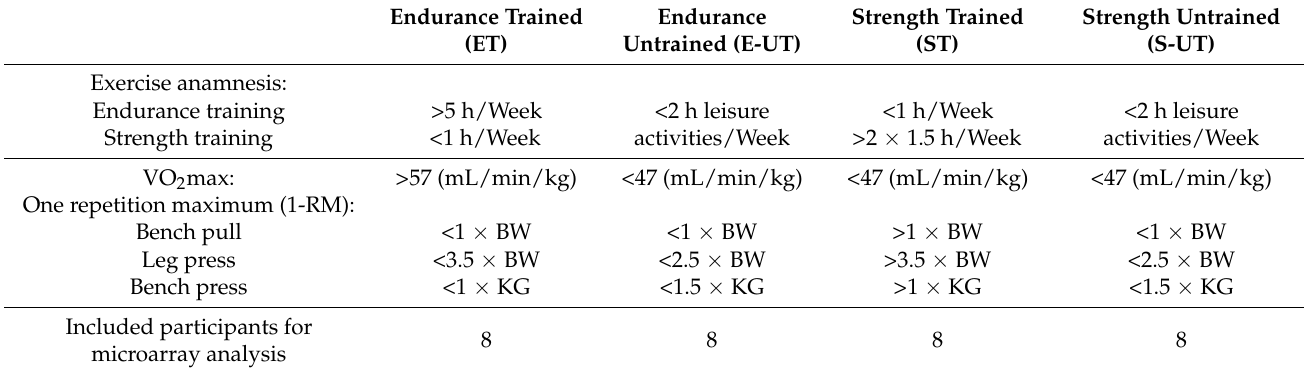
Table 4. Inclusion criteria for highly endurance trained (ET) and untrained (E-UT) and highly strength trained (ST) and untrained (S-UT) participants including training volume (h/week), aerobic capacity (VO 2 max), and strength (one repetition max, 1-RM), body weight